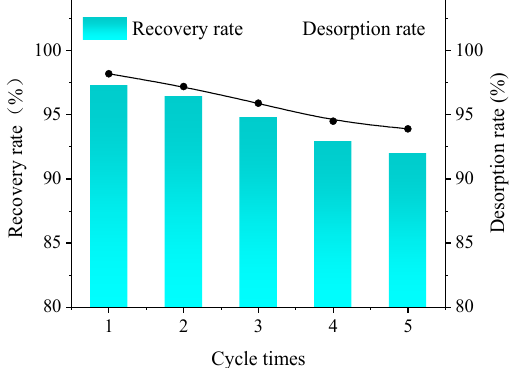
Figure 11. The recovery rates for Pt(CN) 42 − in the mixed solution for five cycles